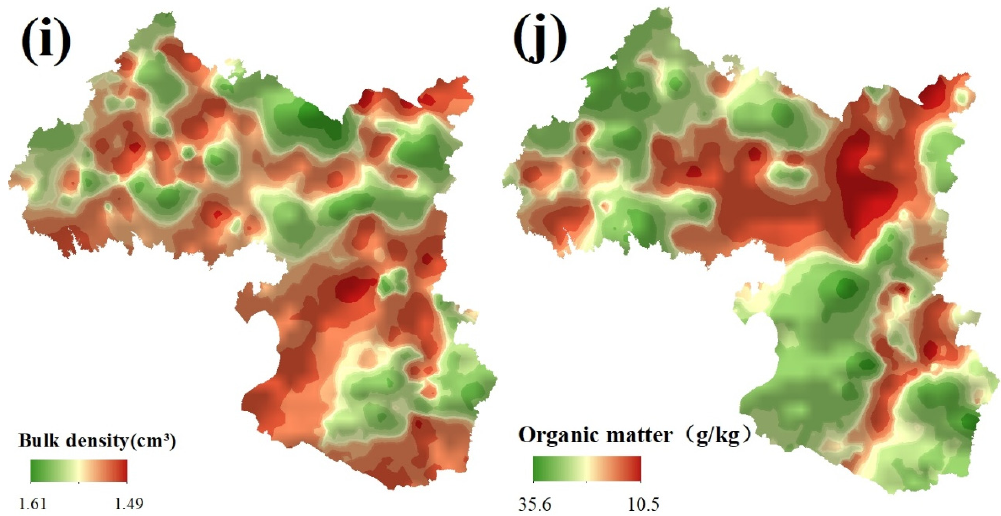
Figure 2. The spatial distribution of natural factors in the research region: ( a ) normalized difference vegetation index (NDVI); ( b ) normalized water index (NDWI); ( c ) soil color index (SCI); ( d ) ratio vegetation index (RVI); ( e ) Vegindex; ( f ) Ironoxide; ( g ) Clayminerals; ( h ) pH; ( i ) Bulk density; ( j ) Organic matter.